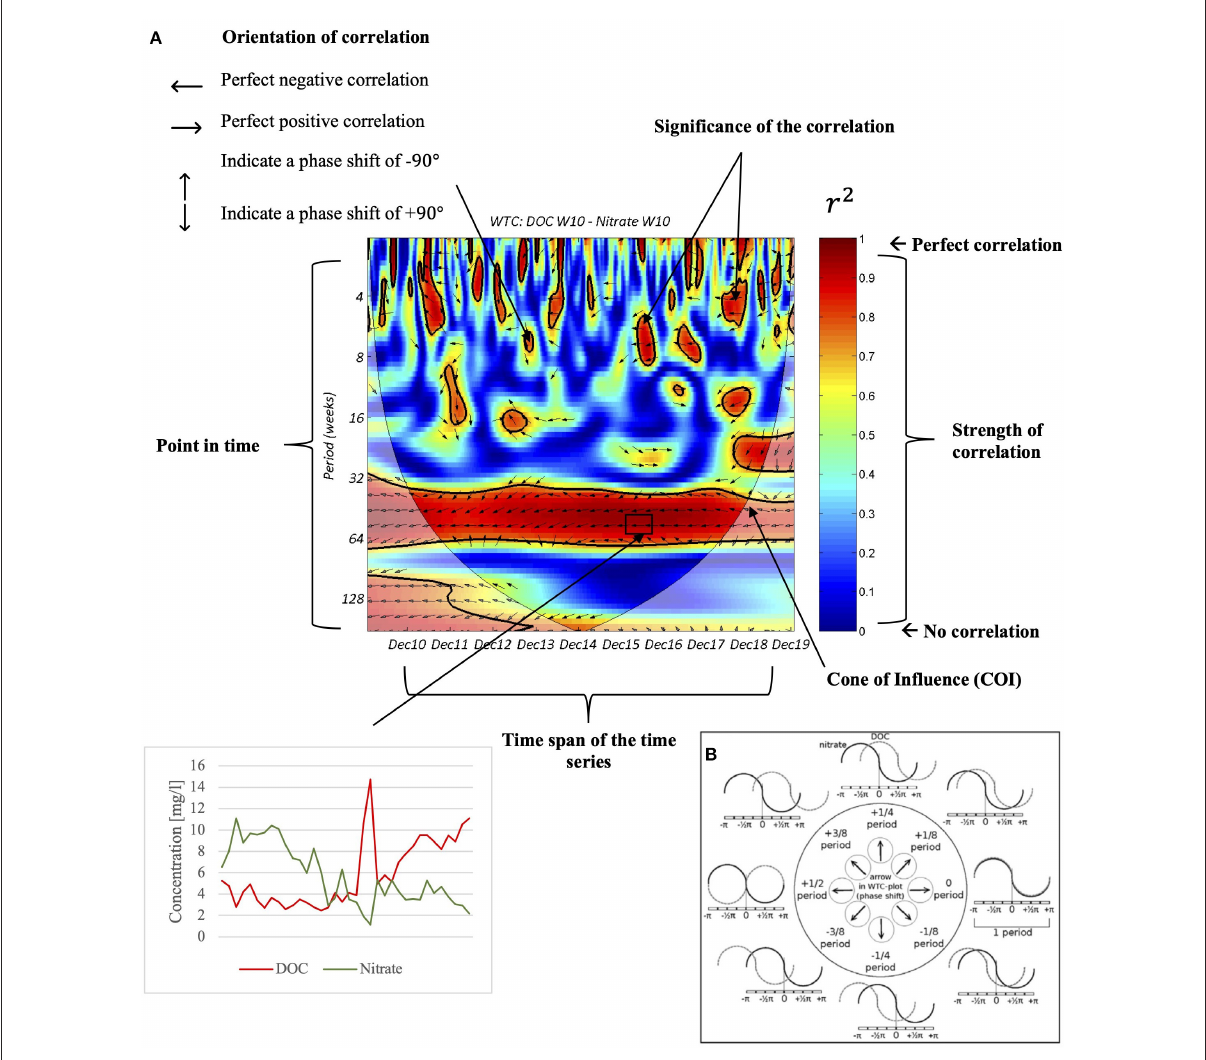
FIGURE2 (A) The key for interpretation of a WTC. (B) The schematic presentation of the phase shifts between DOC and nitrate [Adapted from Weigand et al. (2017)].